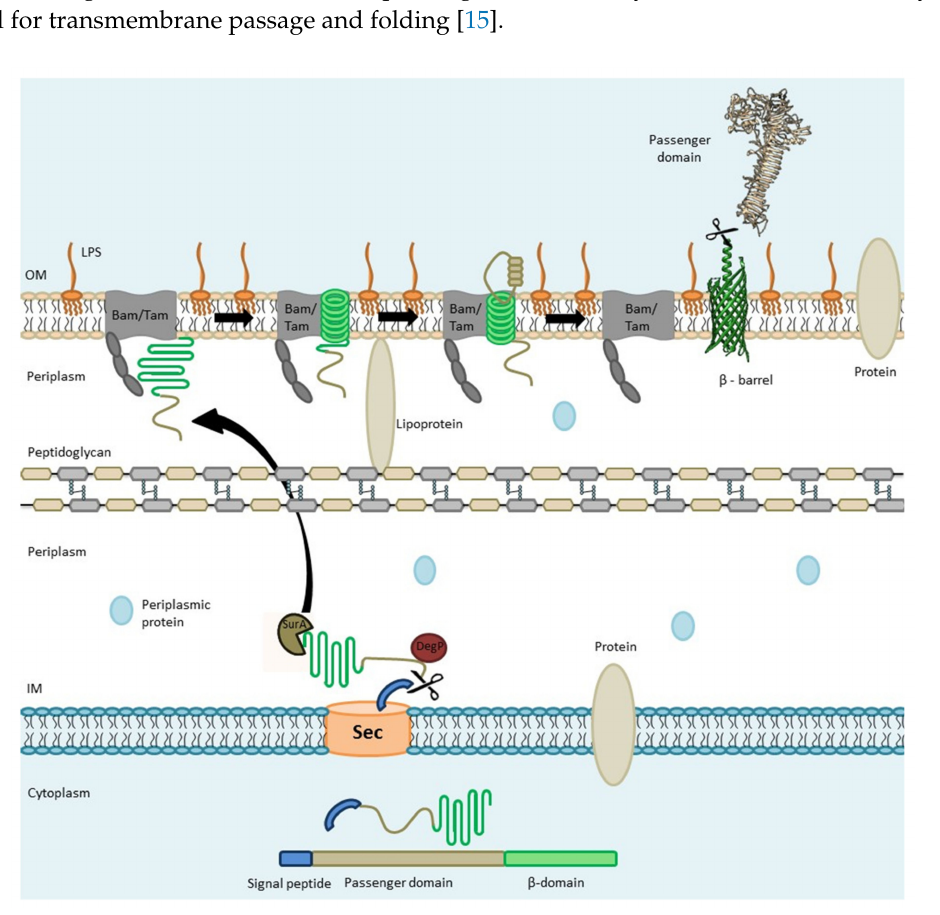
Figure 2. Schematic overview of Autotransporter (AT) processing, export, and secretion: The Signal peptide (SP) mediated by the Sec apparatus, guides translocation of the autotransporter to the periplasmic space. In the periplasm, the AT is kept in a “translocation competent state” by recruiting chaperones such as Skp, SurA, and DegP. Further, the Bam complex assists in the integration of the β -domain into the outer membrane and promotes the translocation of the passenger domain across the outer membrane through a hybrid-barrel mechanism wherein the AT β -barrel and Bam / Tam protein domains interact. Periplasmic chaperones such as SurA and DegP deliver an unfolded autotransporter to BamA / TamA. POTRA domains (gray in beaded structure) are contact sites for the AT protein to be transported. A hybrid-barrel is then formed by insertion of the AT β -strand through the gate region between strands 1 and 16 of the BamA / TamA barrel. Barrel expansion results in pore opening and the passenger domain can then protrude through the hybrid barrel. Subsequently, the passenger domain is released from the hybrid structure and may remain on the bacterial cell surface or can be cleaved for release from the bacterial cell. Adapted from